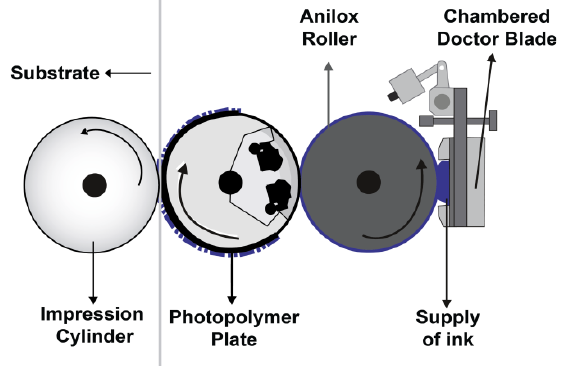
Figure 1. Flexography printing